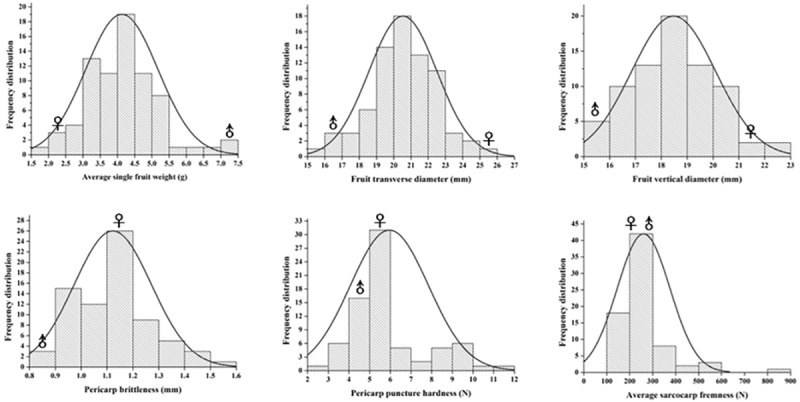
Phenotypic distribution of hawthorn hybrid population crossed from ‘Shandongdamianqiu’ and ‘Xinbinruanzi’.“Shandongdamianqiu” and “Xinbinruanzi’.